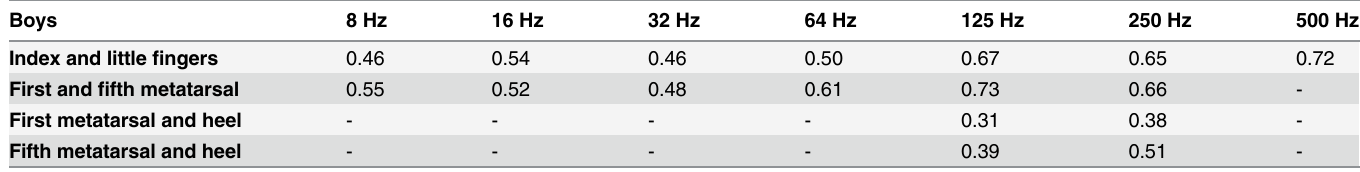
Data are rho-values and only rho-values if rho > 0.30 are presented. The rho-values all showed p < 0.01.